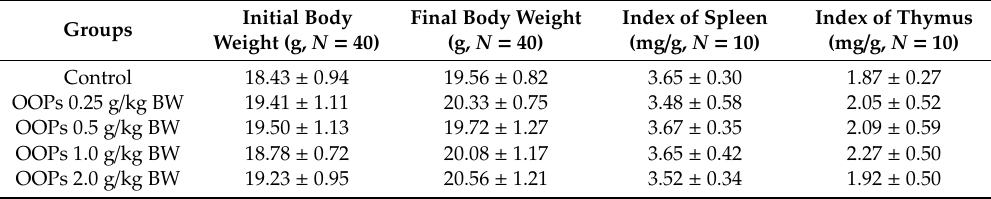
Table 2. E ff ects of OOPs on body weight and immune organ index of